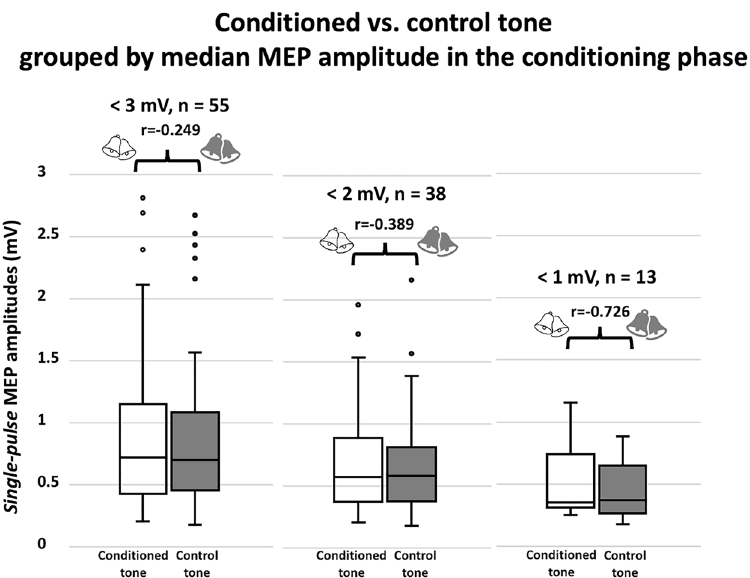
Figure 3. Participant groups according to their median paired-pulse MEP amplitude over the conditioning phase (i.e., < 3 mV, < 2 mV, < 1 mV). For participants with a median paired-pulse MEP amplitude during conditioning < 3 mV (n = 55), the difference between MEP amplitude for conditioned (white box-whiskers) vs. control tone (dark box-whiskers) in the test phase was not significant and the effect size was small ( p = 0.06, 54% responder rate, r = − 0.249). < 2 mV (n = 38) the responder rate increased to 61% and effect size increased to moderate (r = − 0.389). < 1 mV (n = 13), responder rate increased further to 79% and effect size increased to large (r = − 0.727). These findings suggest that the effect of conditioning related on the height of the paired-pulse MEP amplitudes during the conditioning phase. The top of each box indicates the 1st quartile, the bottom the 3rd quartile. The horizontal line within the box marks the median, whiskers indicate minimum and maximum, dots